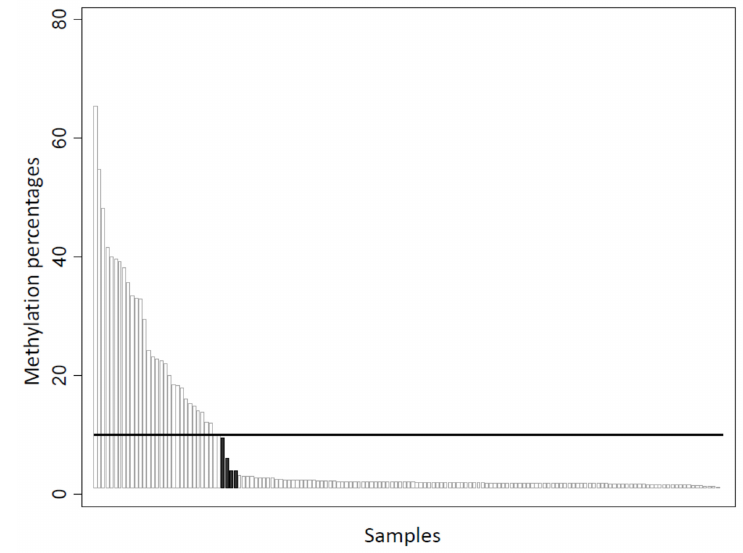
Figure 2. Correlation between methylation-specific PCR and EpiTYPER® MassARRAY® methylation evaluation ( n = 153). Black columns indicate discordant cases ( n = 4, methylation percentage assessed by MassARRAY ® = 9.5, 6, 4, and 4), using a positivity cut-o ff of